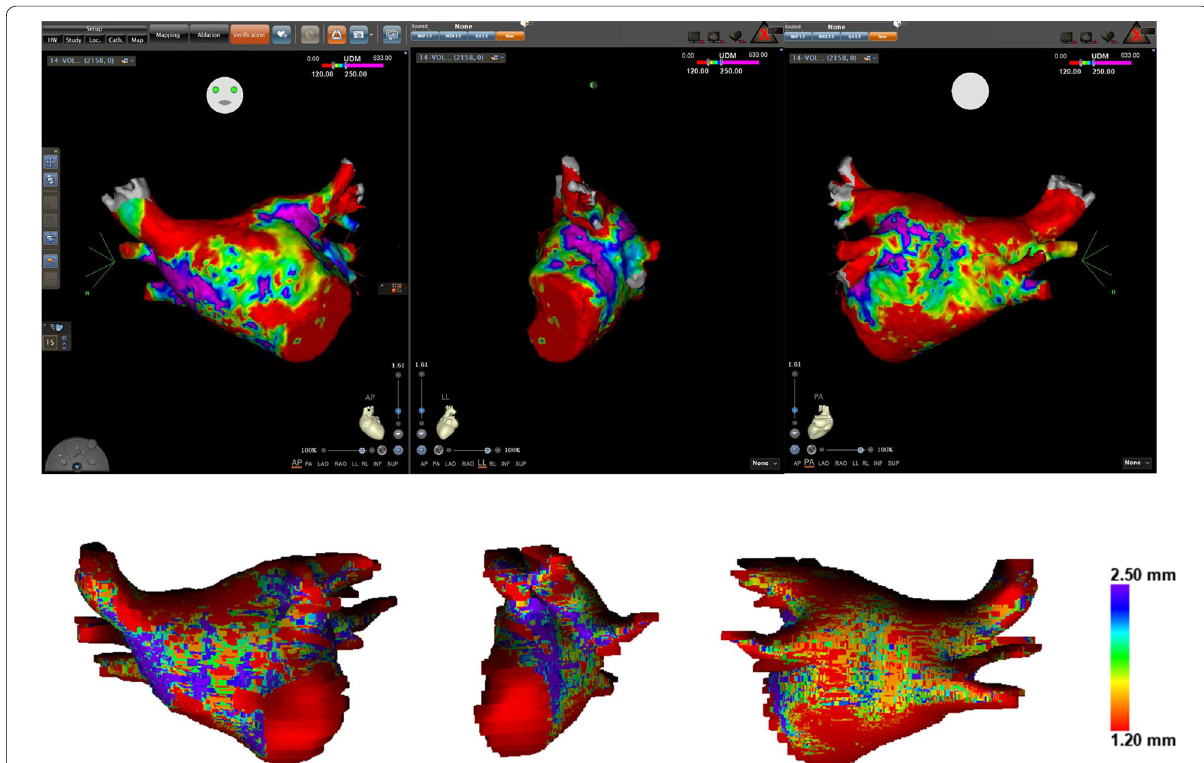
Fig. 6 During the ablation procedure, LAWT was displayed on the CARTO system. The 3D LAWT map calculated with the AMBER software (bottom) was displayed on the CARTO system